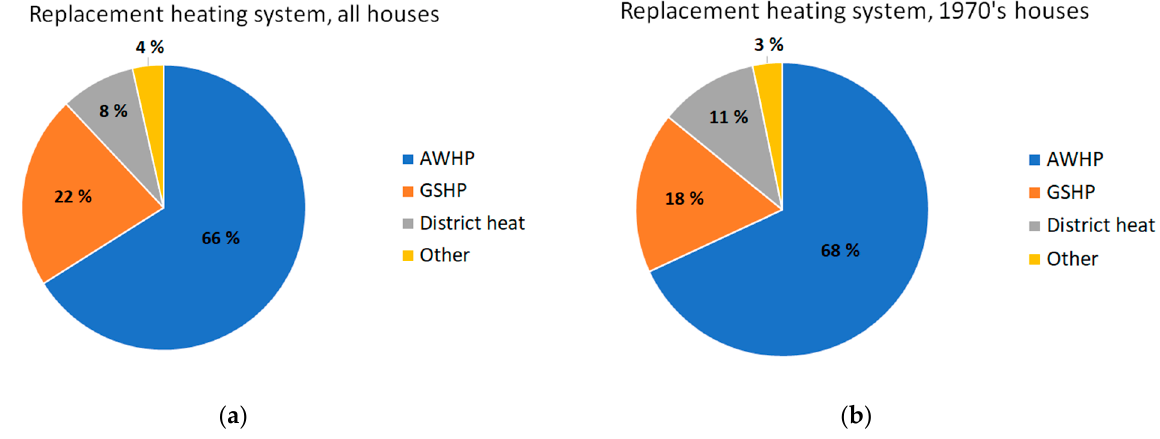
Figure 3. Type of the new heating system installed with the ELY grant ( a ) for all building ages, and ( b ) for buildings built in the